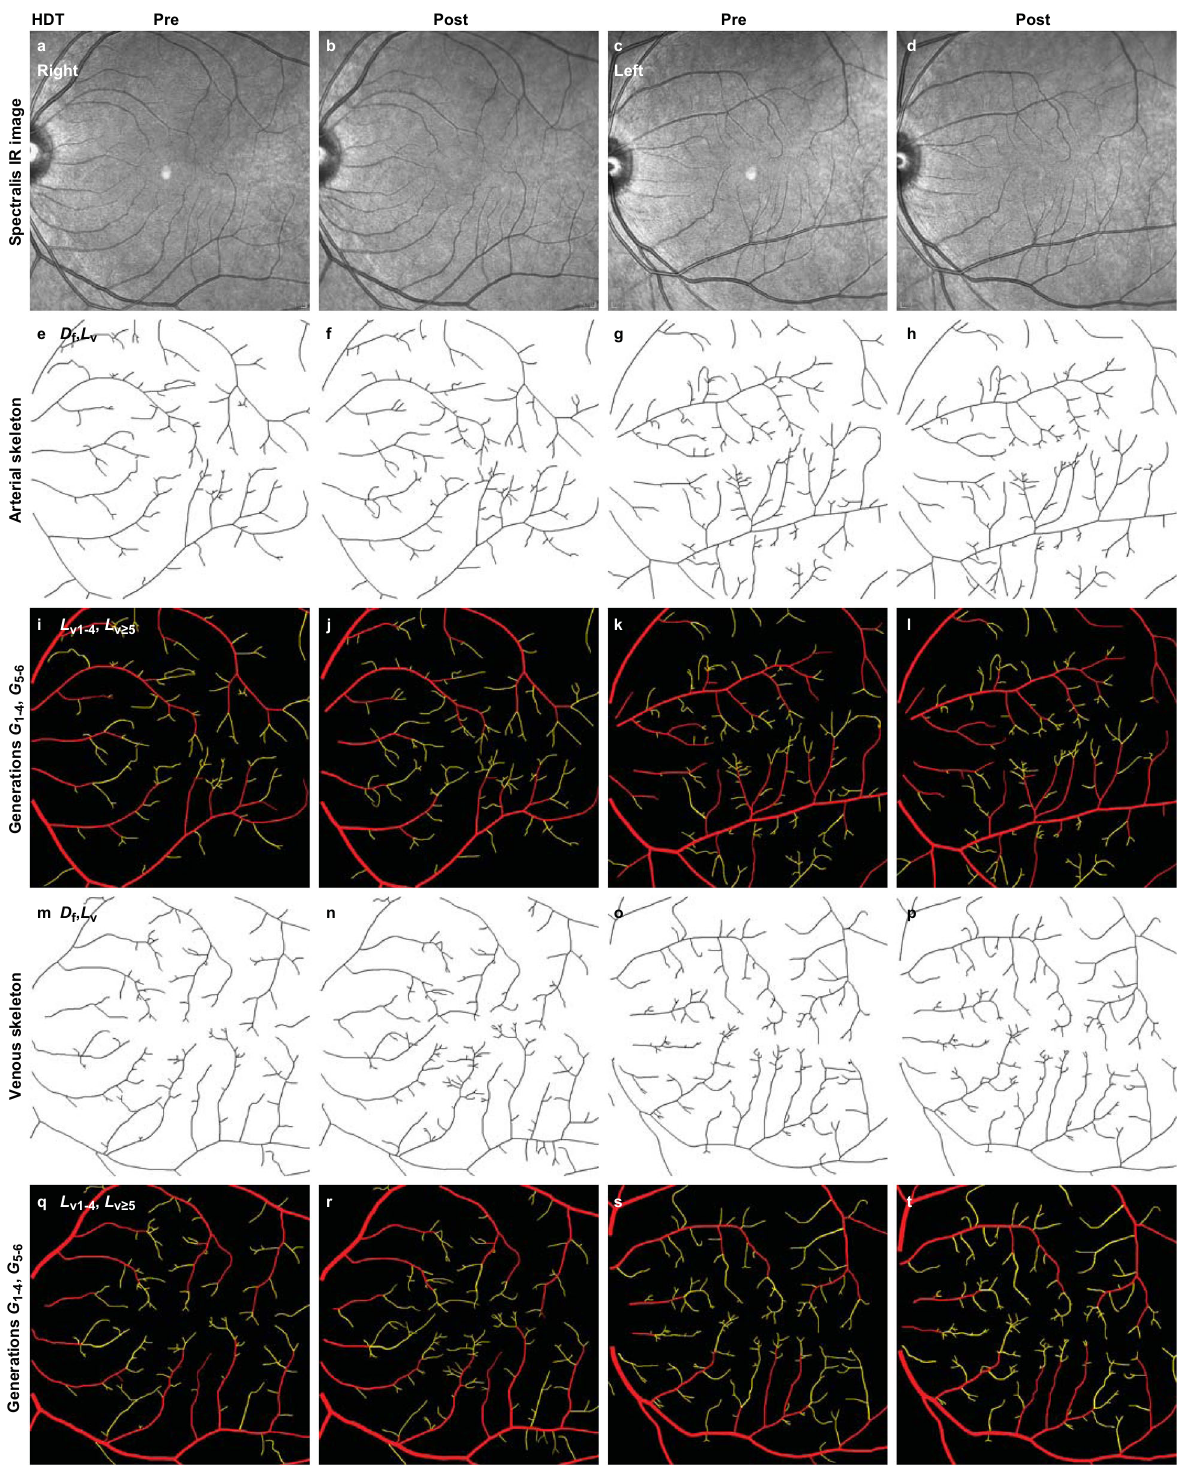
Fig. 3 Representative increases in vascular density before and after 70 days of HDT. For the right and left retinas of subject 4 (Table 2; Supplementary Table 1), vascular density increased slightly according to mean values except for the left arterial density that remained essentially unchanged. As illustrated in Fig. 2, binary arterial and venous trees from grayscale retinal images ( a – d ) were analyzed by VESGEN as vascular skeletons ( e – h , m – p ) and branching trees grouped into large ( G v1-4 , red) and small ( G v5-6 , yellow) generations ( i – l , q – t ). Right arterial and venous length densities ( L v ) before HDT, 13.34 × 10 – 4 μ m/ μ m 2 and 13.37 × 10 – 4 μ m/ μ m 2 ; after, 13.97 × 10 – 4 μ m/ μ m 2 and 15.17 × 10 – 4 μ m/ – 4 μ m/ μ m 2 and 15.07 × 10 – 4 μ m/ μ m 2 ; after, 16.00 × 10 – 4 μ m/ μ m 2 and μ m 2 . Left arterial and venous length densities ( L v ) before HDT, 16.07 × 10 16.04 × 10 – 4 μ m/ μ m 2 . Scale bars ( a – d ), 200 μ